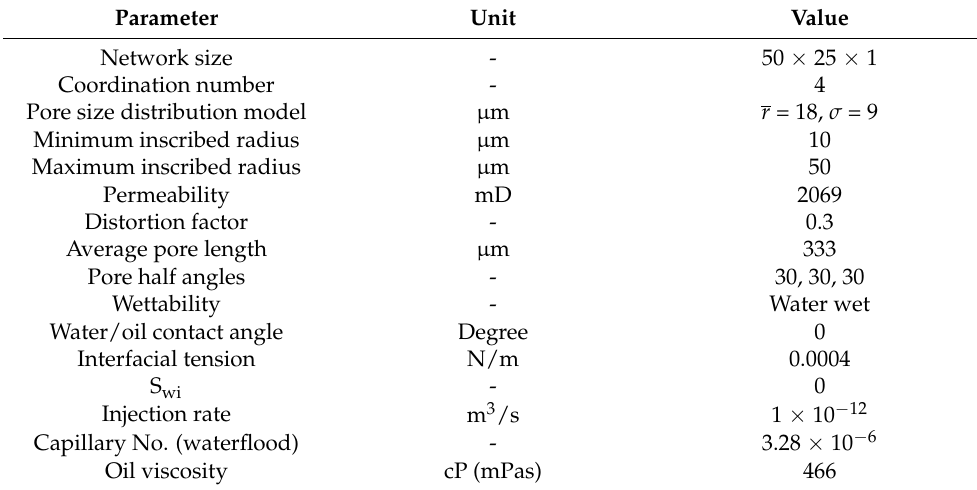
Table 2. Pore network